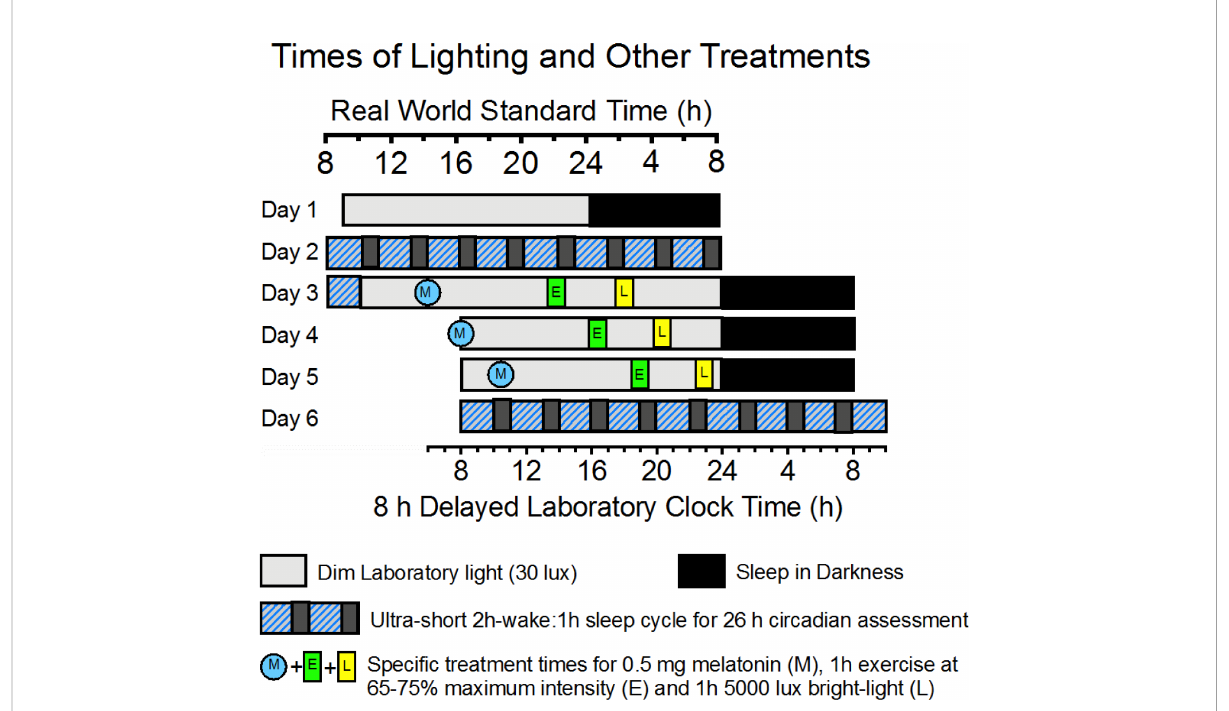
FIGURE 4 Schematic of laboratory light:dark cycles and timing of scheduled melatonin (M), exercise (E), and bright Light (L) treatments speci fi ed in the text and Table 1. The fi gure depicts speci fi cs only for the Melatonin + Exercise + Bright-Light treatment For consistency, all times in Table 1 are real world Arizona Standard Time, even after the 8 h delay of Laboratory Clock Time (bottom